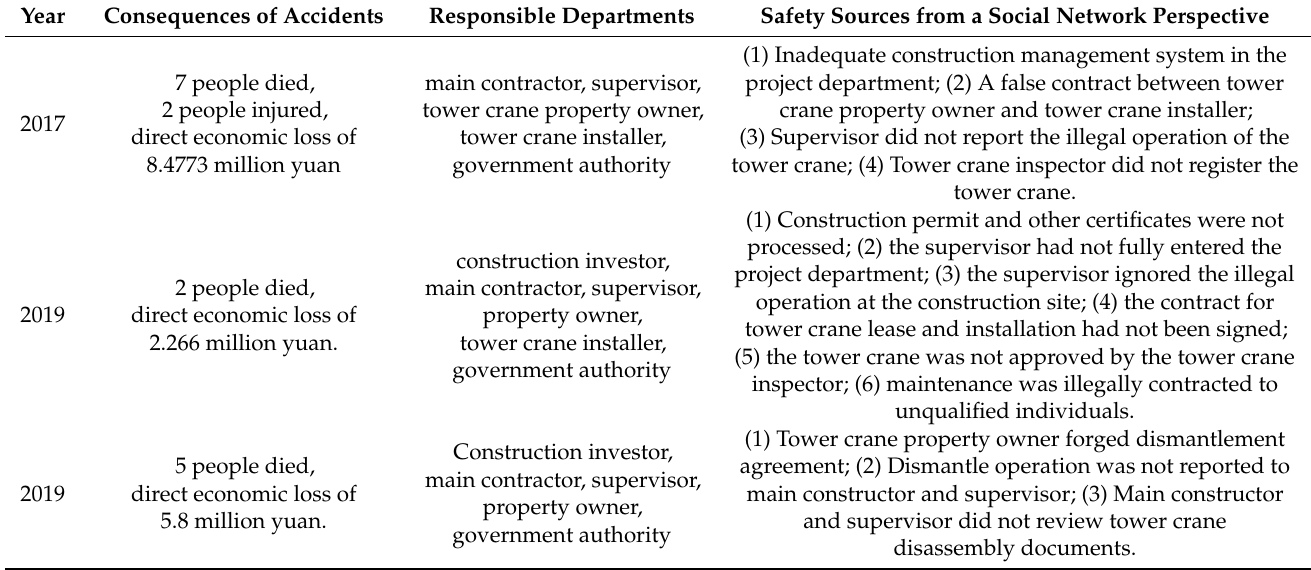
Table 1. Common tower crane accidents in China in recent